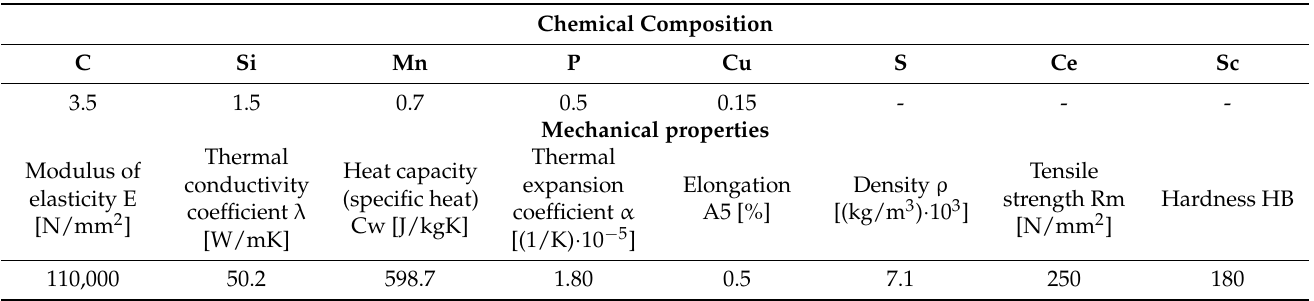
Table 1. Chemical composition in % of elements for cast iron discs used during the tests and